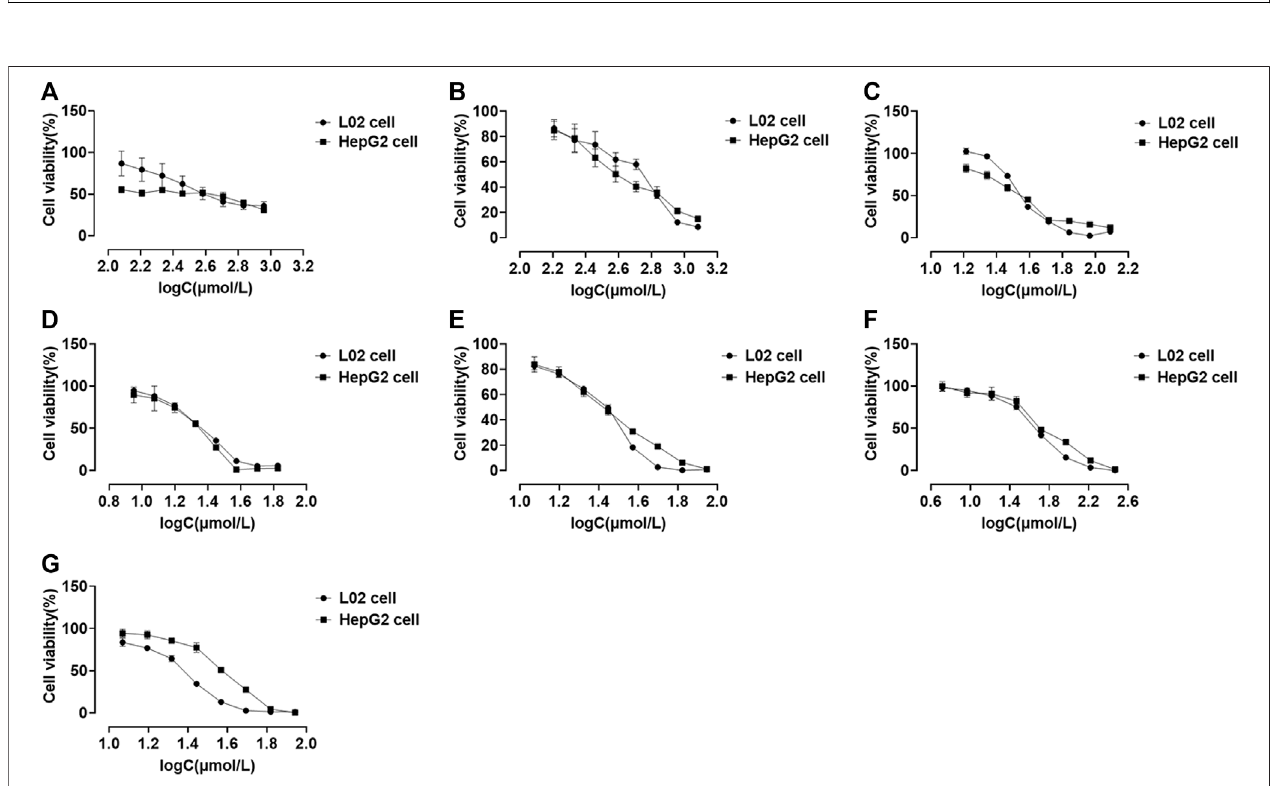
FIGURE5| CellviabilityofL02and HepG2cells treatedwith psoralen (A) ,isopsoralen (B) , bavachin (C) ,psoralidin (D) ,bavachinin (E) ,neobavaiso fl avone (F) ,and bakuchiol (G) . Values are presented as mean ± SD, n (cid:1) 6.